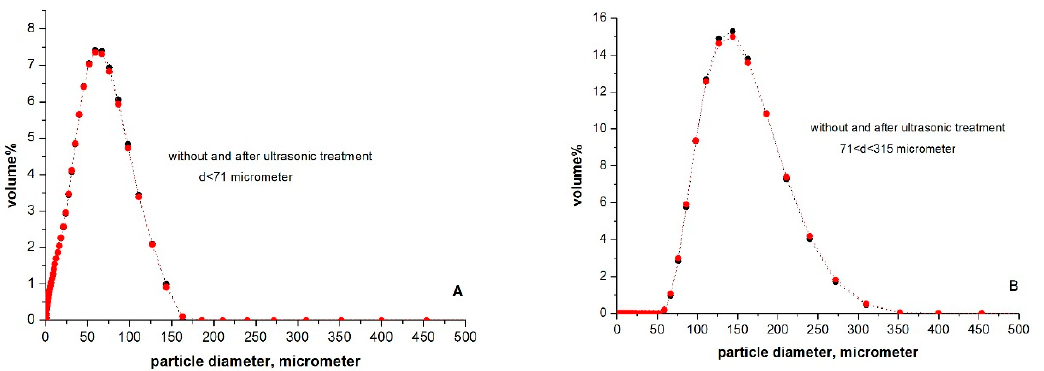
Figure 2. ( A ) The measured particle size distribution curve by laser di ff raction in an aqueous suspension Figure 2. (A) The measured particle size distribution curve by laser diffraction in an aqueous containing smaller than 71 µ m of microcline particles ( d < 71 µ m). ( B ) The measured particle size suspension containing smaller than 71 μ m of microcline particles ( d < 71 μ m). (B) The measured distribution curve by laser di ff raction in an aqueous suspension containing microcline particles in the particle size distribution curve by laser diffraction in an aqueous suspension containing microcline range from 71 µ m up to 315 µ m (71 µ m < d < 3 15 µ particles in the range from 71 μ m up to 315 μ m (71 μ m < d < 3 15 μ m).